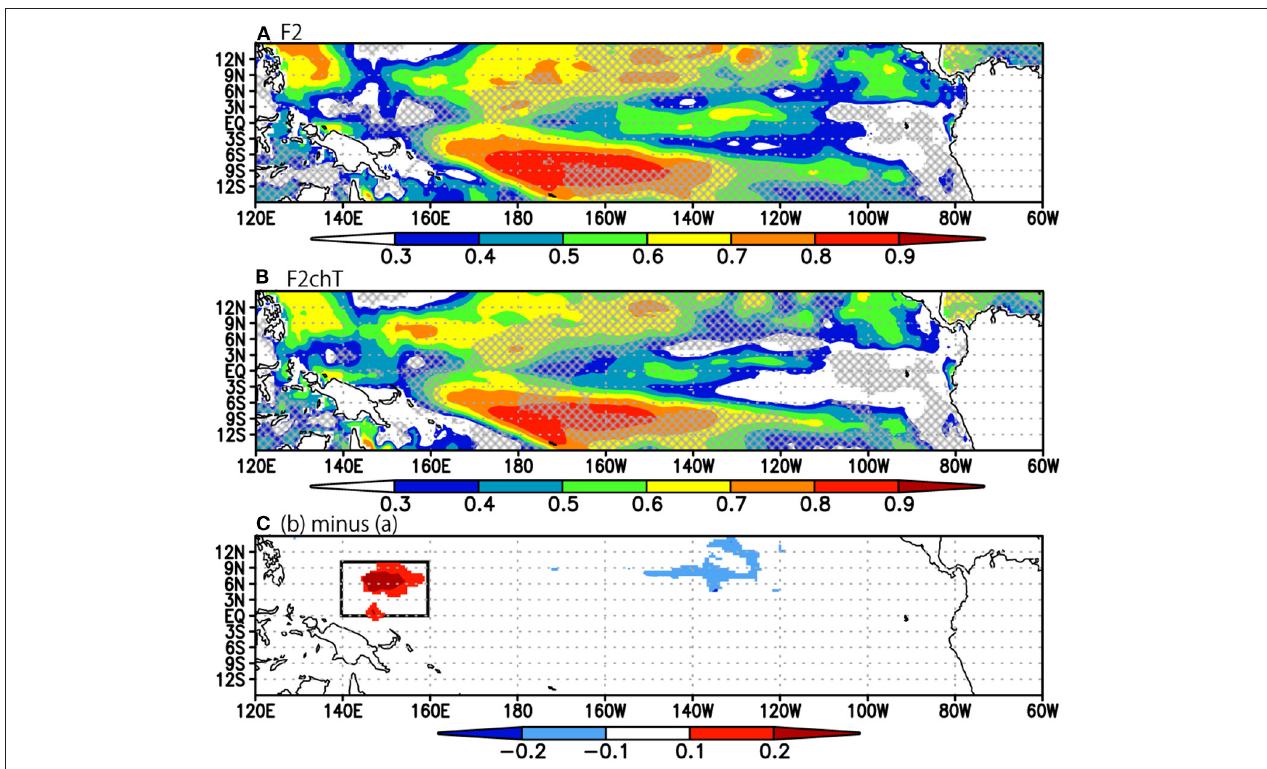
FIGURE 3 | (A) Correlation skills for prediction of SST anomalies in June–August average issued on January 1st by the 2000–2020 re-forecast experiments by the F2 system. Values lower than the persistence (lag auto-correlation of observation) are shown by hatching. (B) Same as (A) , but for the F2chT system. (C) (B) minus (A). The values which are statistically significant beyond the 95% confidence levels on the paired t-test are shown in color shades. The target region (140 ◦ E − 160 ◦ E, equator − 10 ◦ N) is shown by a black box.